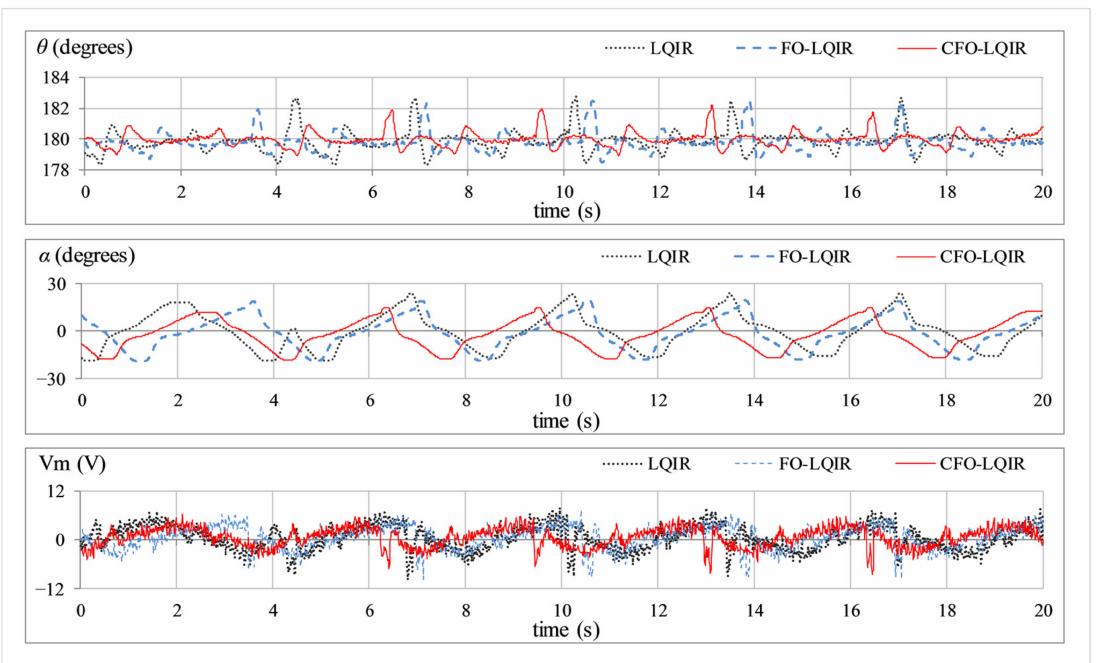
Figure 5. SRIP’s response under impulsive